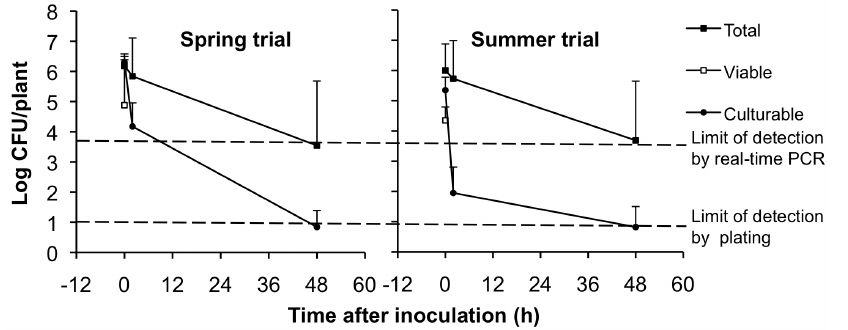
Figure 4. E.coli O157:H7 ATCC 700728 survival on lettuce in the field. E. coli O157:H7 amounts were measured by plate count (culturable), real-time PCR (total), and PMA real-time PCR (viable). Viable amounts were below the detection limit (3.7 log CFU/plant or leaf) at 2 and 48 h. The mean 6 stdev of 12 lettuce plants at each sampling time is shown.